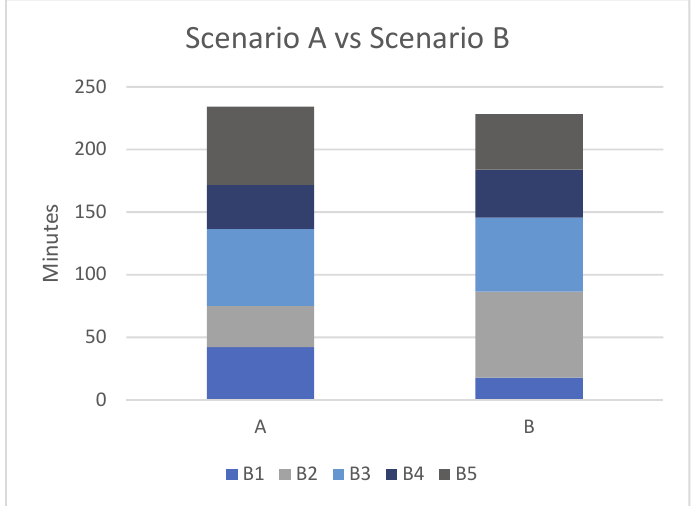
Fig. 7 . Comparison of the simulated